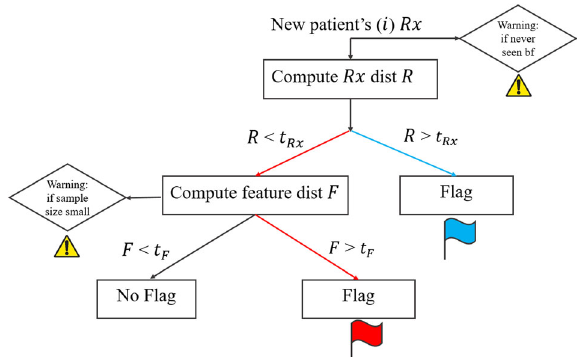
Fig. 5 Model architecture. We use dissimilarity metrics R and F to fl ag incoming new patient. If prescription is uncommon ( R is greater than t Rx ), we fl ag it as blue. Otherwise, we compute feature distance F , if it is greater than cut off t F , we fl ag it as red indicates that feature mismatches with its prescription. We can also give warnings as